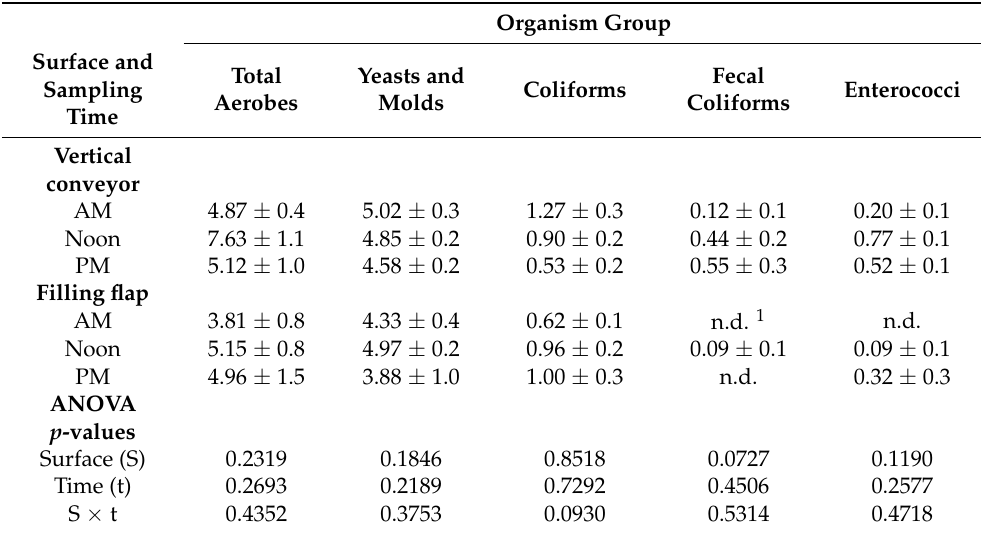
Table 3. Population densities (log 10 ( x + 1) colony-forming units per cm 2 ± standard error) of environmental and fecal indicator organisms on surfaces that are found only on top-loader blueberry harvesters (three each in 2015 and 2016) sampled at different times of the day.